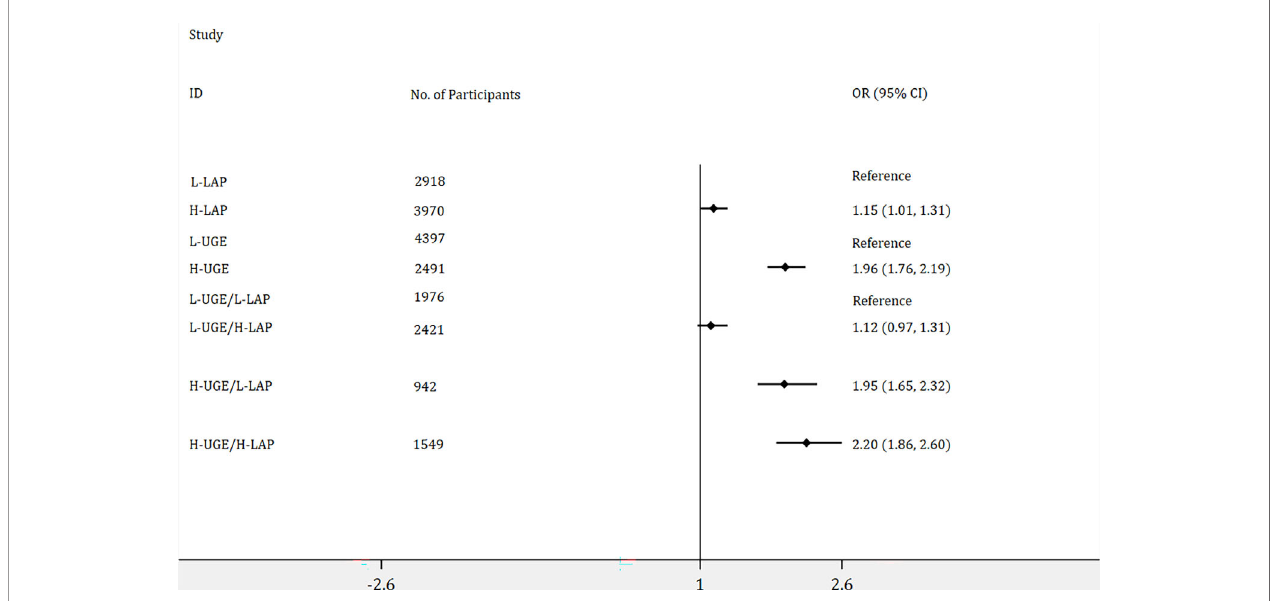
FIGURE 3 | Logistic regression analyses of odds ratios for prediabetes (PDM) with adjustment of age, genders, blood pressure, total cholesterol, body mass index, blood urea nitrogen, and creatinine. The association of lipid accumulation product (LAP) with the risk of PDM was assessed by dividing the participants into two groups: (1) low LAP (L-LAP), (2) high LAP (H-LAP). The L-LAP group was used as a reference in the analysis. The association of urine glucose excretion (UGE) with the risk of PDM was assessed by dividing the participants into low UGE (L-UGE) group and high UGE (H-UGE) group. The L-UGE group was used as a reference in the analysis. The joint association of UGE and LAP was assessed by dividing the participants into four groups: (1) L-UGE/L-LAP, (2) L-UGE/H-LAP, (3) H-UGE/L- LAP, (4) H-UGE/H-LAP. The L-UGE/L-LAP group was used as a reference in the analysis. The forest plot was displayed in odds ratio and 95% con fi dence